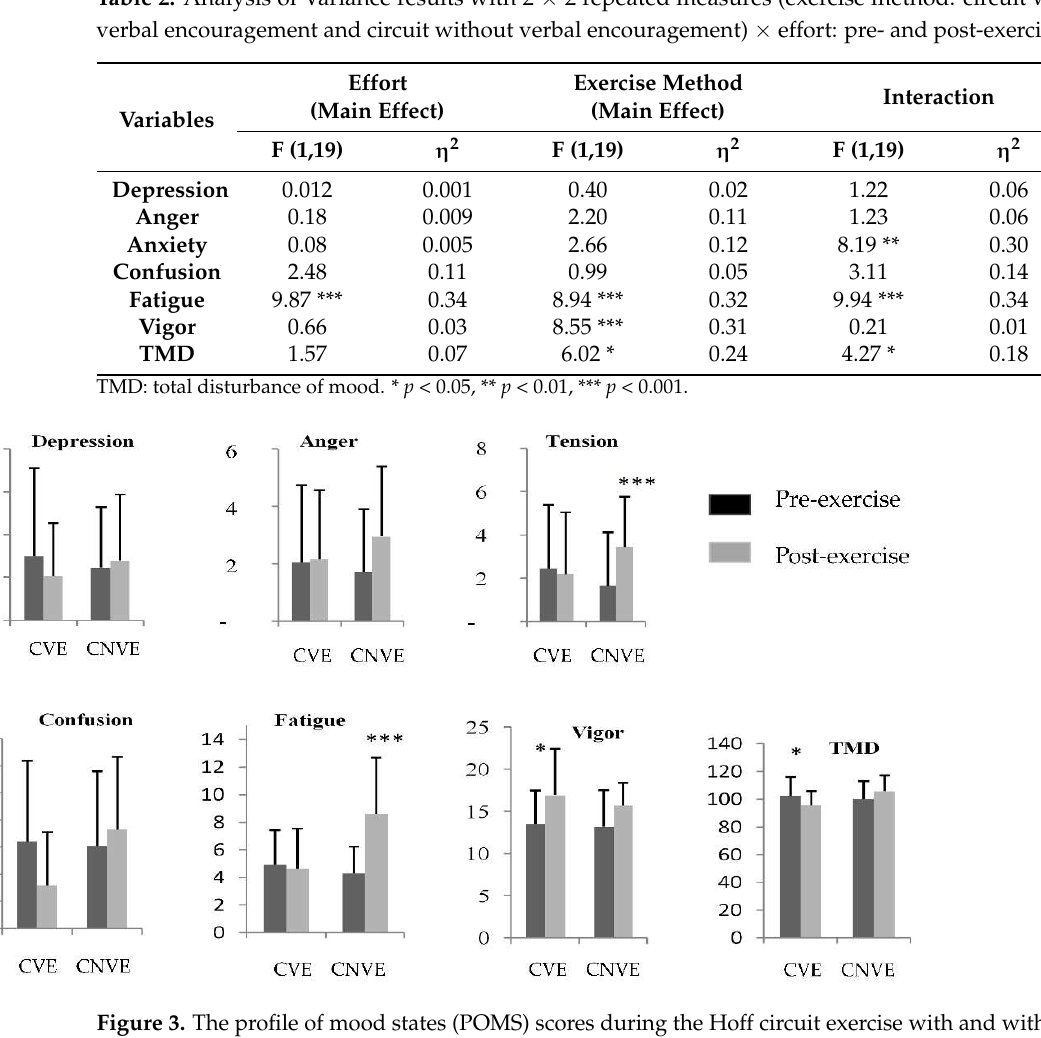
Figure 3. The profile of mood states (POMS) scores during the Hoff circuit exercise with and without verbal encouragement during pre-exercise and post-exercise measures. CVE, circuit exercise with verbal encouragement; CNVE, circuit exercise without verbal encouragement; TMD, total mood disturbance. Error bars indicate within-subject standard deviation. * a significant difference between pre-exercise and post-exercise values. * p < 0.05, *** p < 0.001.